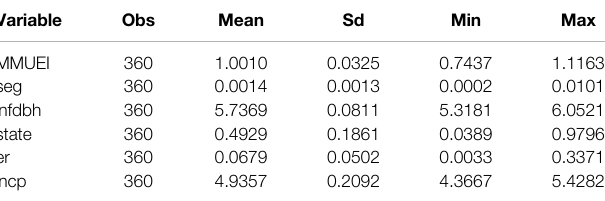
TABLE 6 | Summary statistics of variables in the benchmark